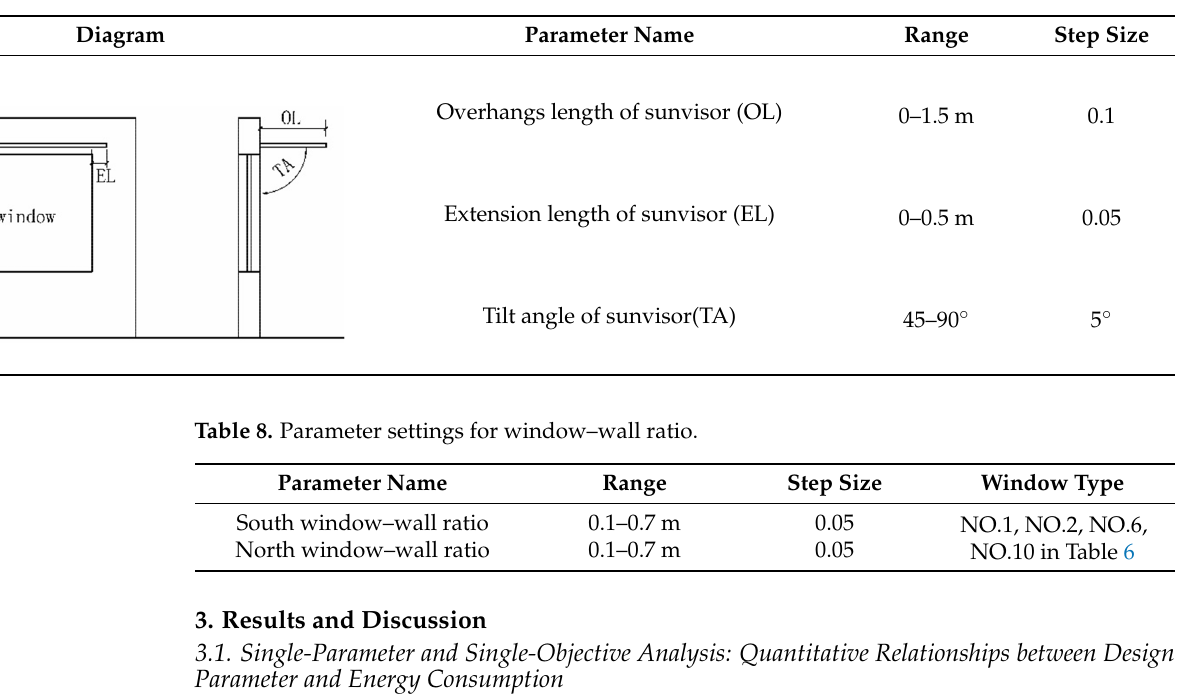
Table 7. Parameter settings for the external shading system.